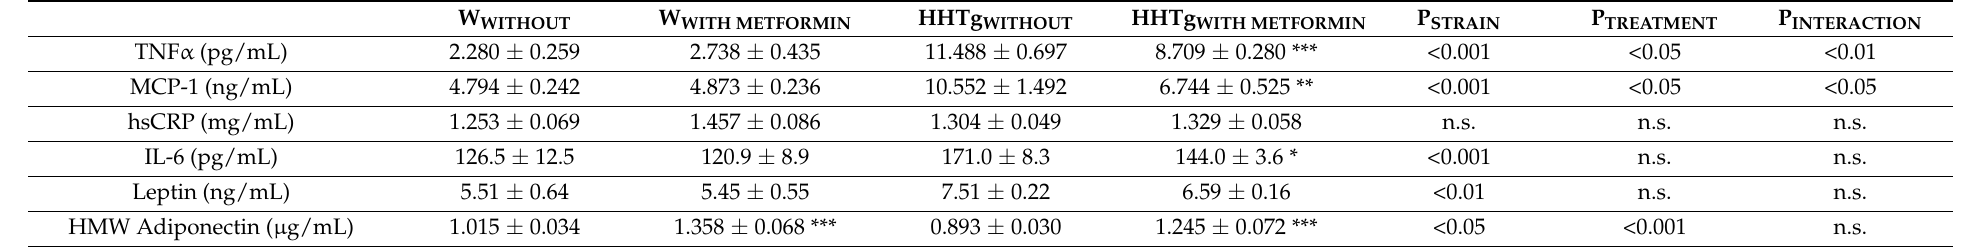
Table 2. Inflammatory markers and adipocytokines in Wistar control ( W WITHOUT ) and hereditary hypertriglyceridemic ( HHTg WITHOUT ) rats after metformin administration ( W WITH METFORMIN ), ( HHTg WITH METFORMIN